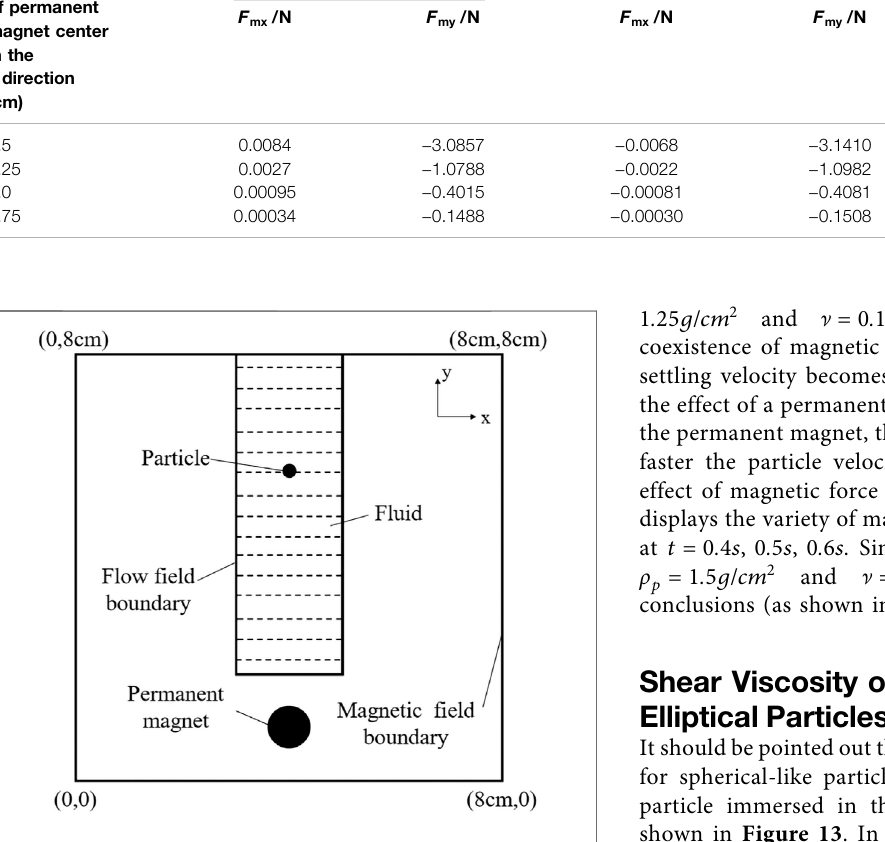
Frontiers in Materials |